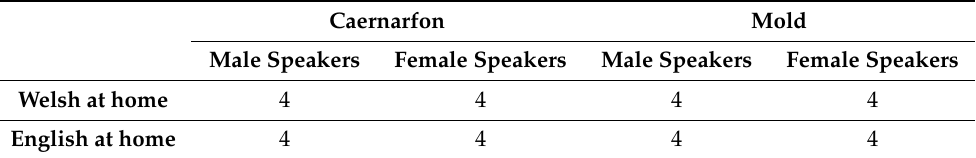
Table 1. The sample. Caernarfon Mold Male Speakers Female Speakers Male Speakers Female Speakers Welsh at home English at home